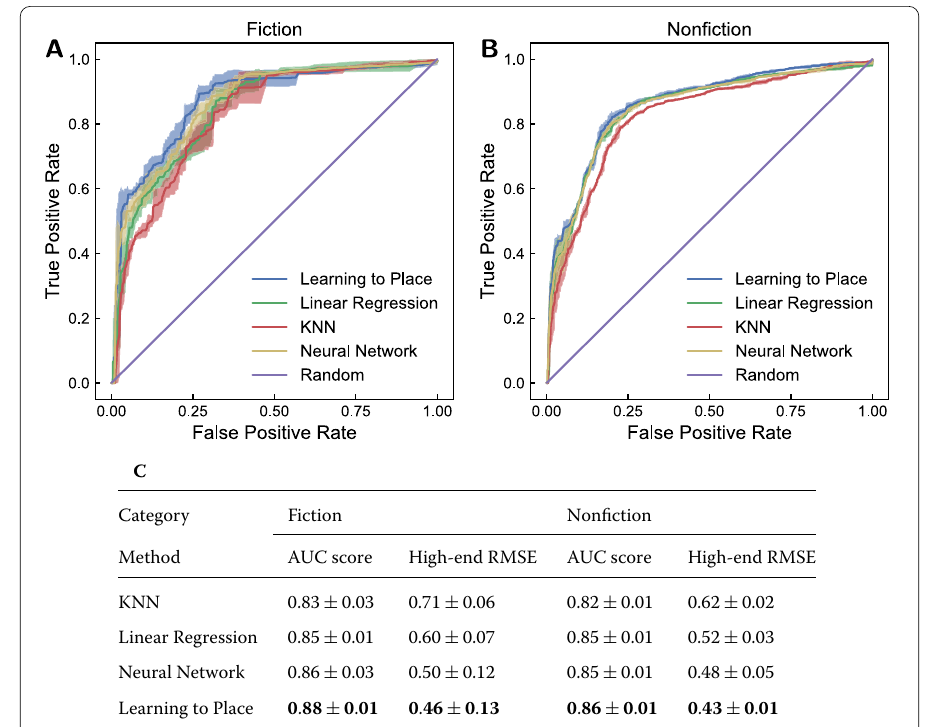
Figure 8 ROC curve and measurement table for one year sales. ROC curve for ( A ) fiction books and ( B ) nonfiction books. The LearningtoPlace method performs better than LinearRegression as well as the KNN Baseline. NeuralNetwork achieves comparable ROC curves. Band around the curve represents the standard deviation of the score across 5-fold cross validation. ( C ) Measurement Table comparing the performance of KNN, Linear Regression, Neural Network and Learning to Place. A higher AUC is better; a lower RMSE is better. We see that LearningtoPlace outperforms in every measure